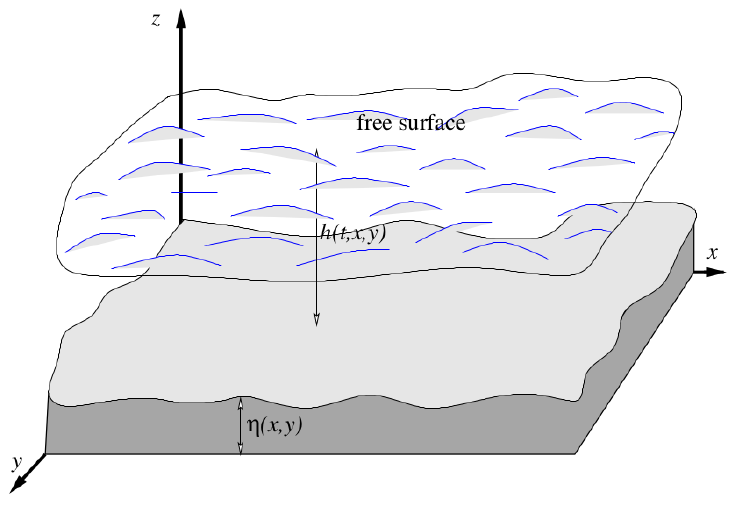
Figure 1. Domain